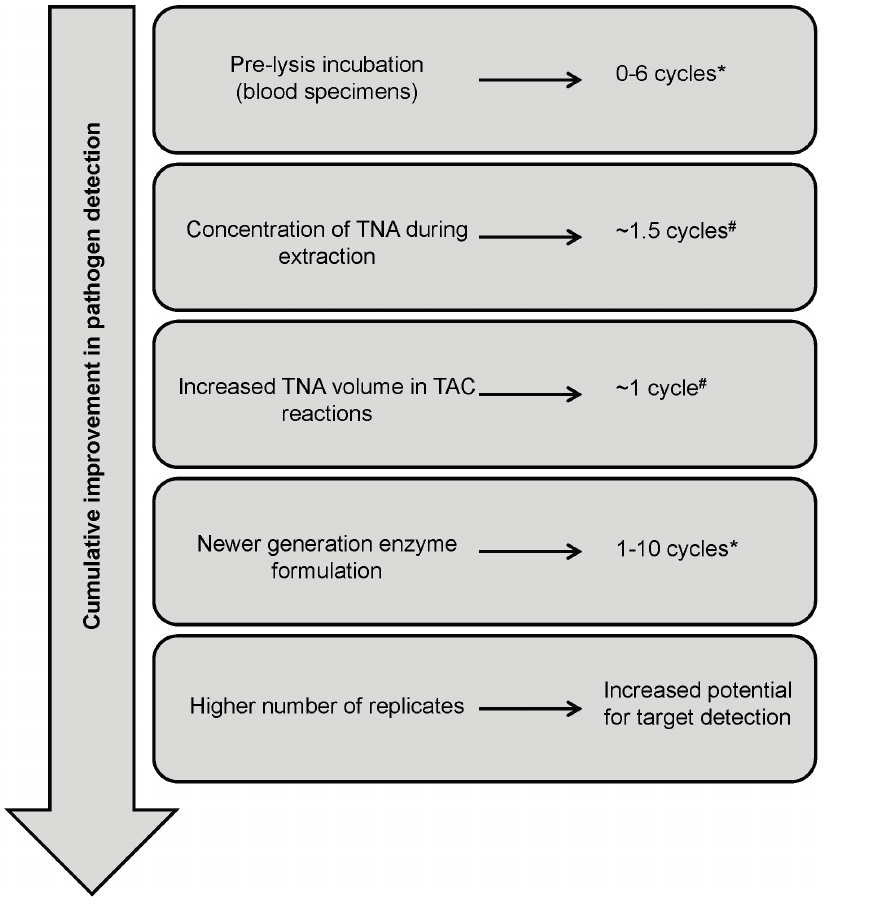
Figure 5. Cumulative improvement of pathogen detection with optimization of experimental parameters. Potential improvement in Ct value (number of cycles) achieved by optimizing each experimental parameter. *Number of cycles gained varies based on organism, target, and specimen type. # Theoretical improvement calculated based on assumption of 3.3 cycle difference with 10-fold change in nucleic acid concentration.